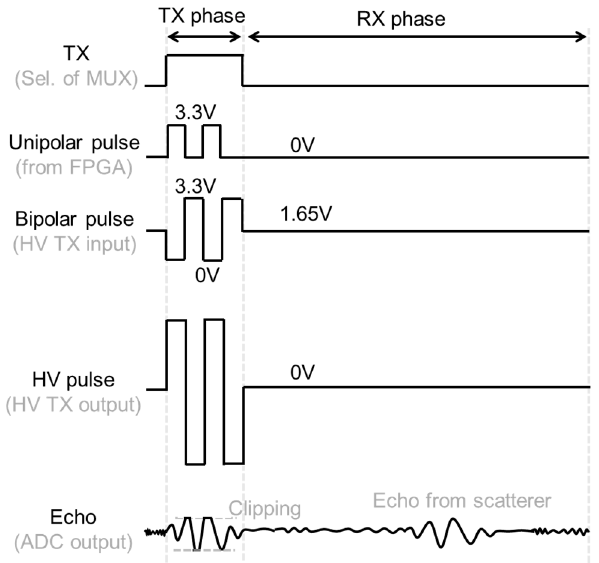
Figure 4. Timing diagram of high-voltage TX pulser; TX: transmitter, RX: receiver, MUX: multiplexer, HV: high voltage, ADC: analog-to-digital converter.